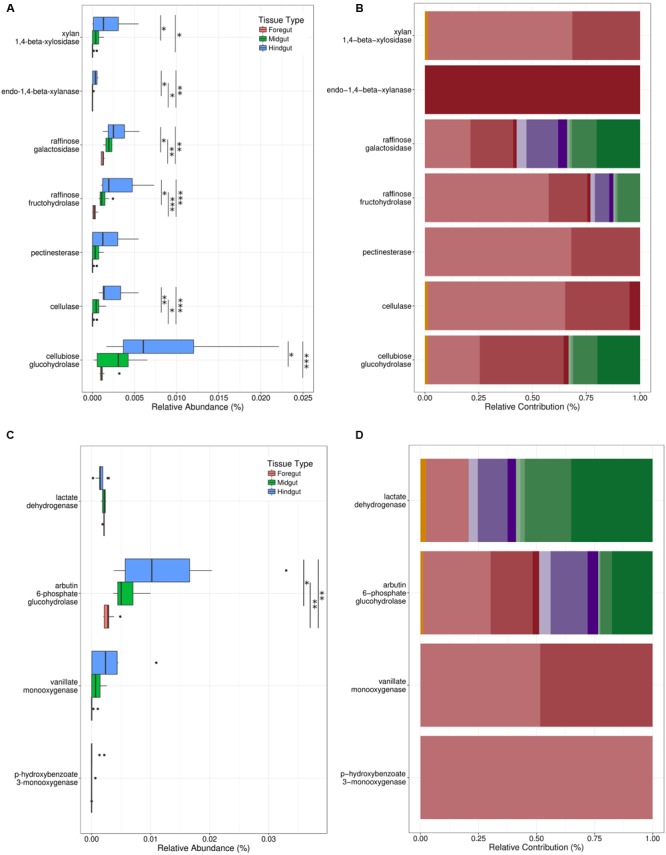
Relative abundance of KEGG orthologs related to (A) carbohydrate metabolism and (B) antimicrobial compound production among tissue types, and the contributions of taxonomic groups (C,D) to ortholog abundance. Key for colors representing taxonomic groups are in Figure 2. Sample sizes are foregut (n = 11), midgut (n = 11), and hindgut (n = 9). ∗p < 0.05, ∗∗p < 0.01, ∗∗∗p < 0.001.